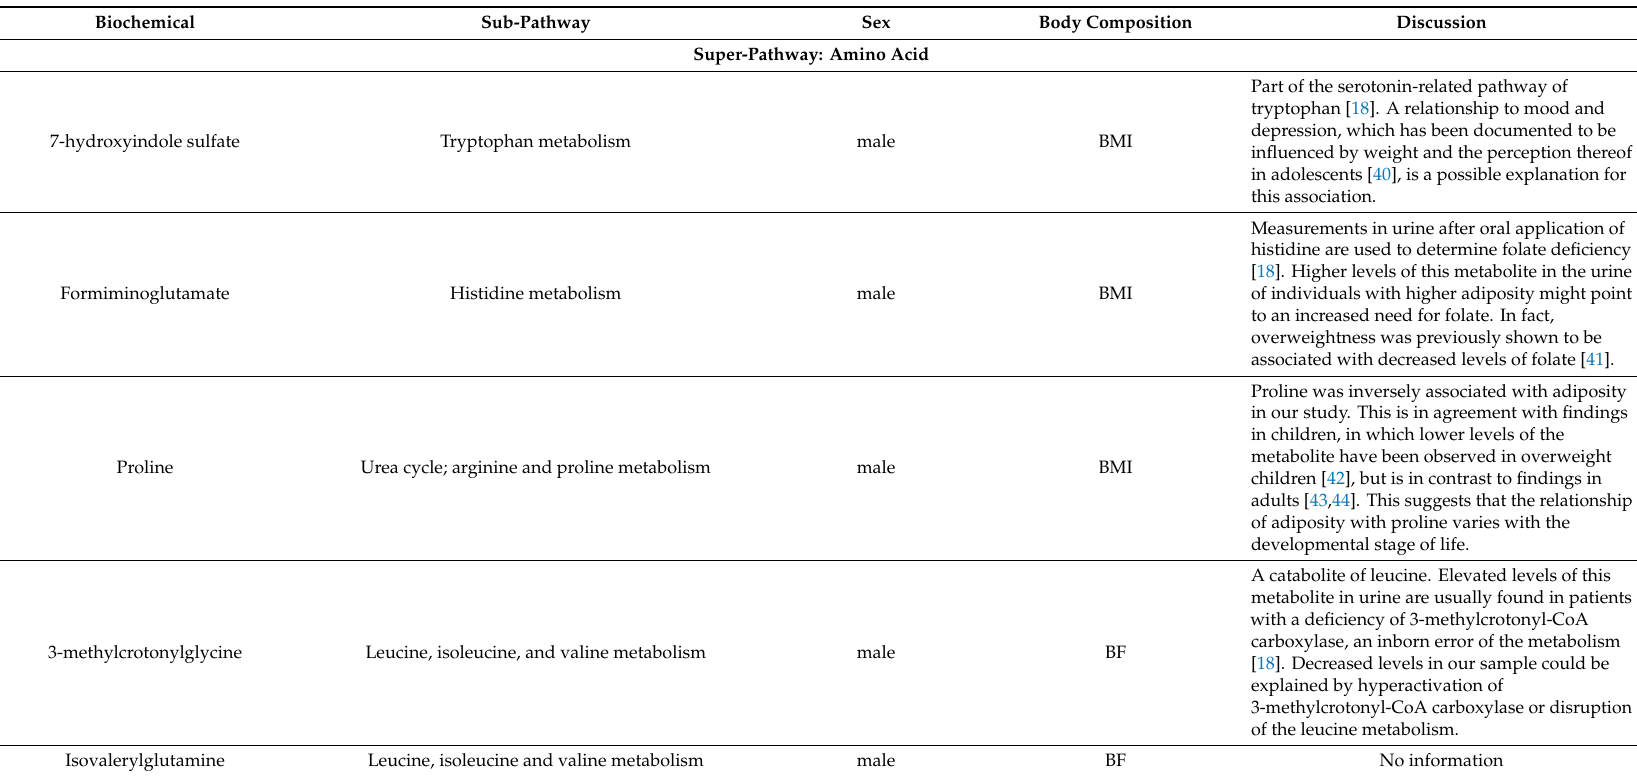
Table A5. Additional discussion for metabolites associated with either BMI or